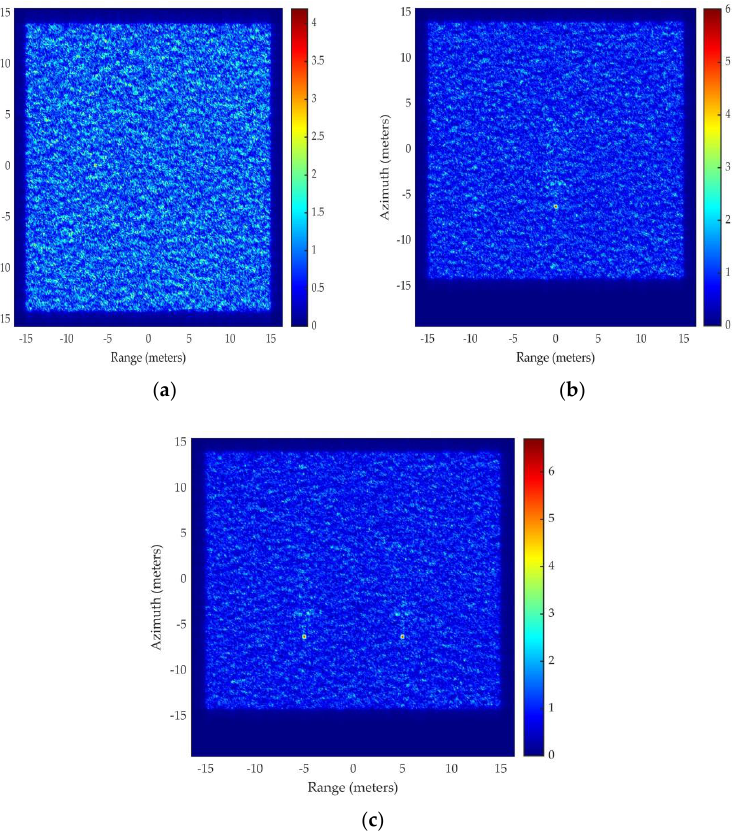
Figure 13. SAR images of a different number of missile−like targets above sea surface: ( a ) only the rough sea surface; ( b ) one missile−like target above sea surface; ( c ) two missile−like targets above the sea surface.